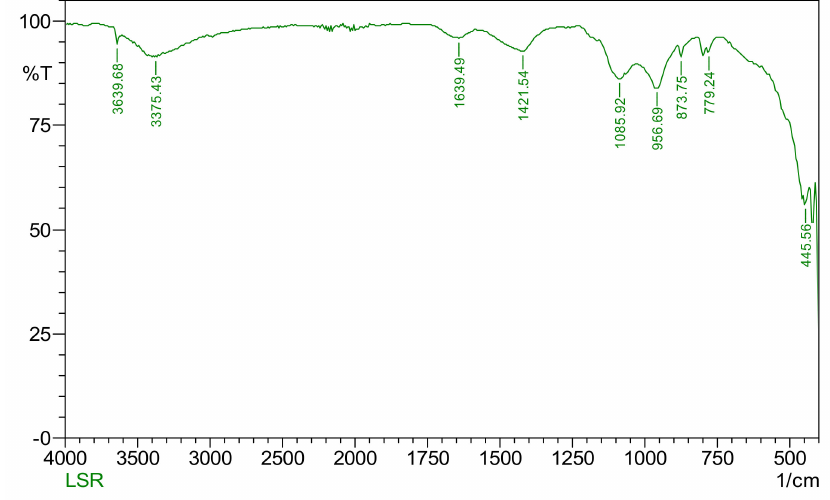
Figure 23. FTIR graph of LSR mortar.